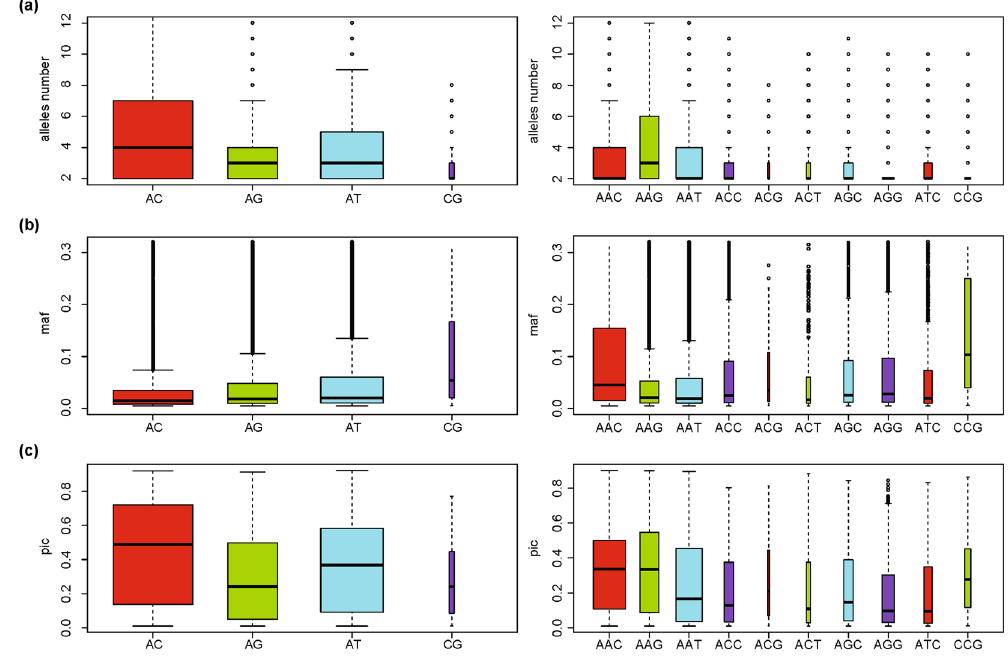
Figure 4. Comparisons of characteristics in distinct motifs. Differences of allele number ( a ), minor allele frequency ( b ) and PIC ( c ) of distinct motifs in dinucleotide (left) and trinucleotide (right) polymorphic SSRs. The CG-enriched motifs, such as CG, CCG, and ACG, usually have a trend of conservation, which is in accordance with the higher allele number, higher PIC, and lower minor allele frequency because of the rarity of opportunities for mutation. The bar width is proportional to the square root of the number of observations in the